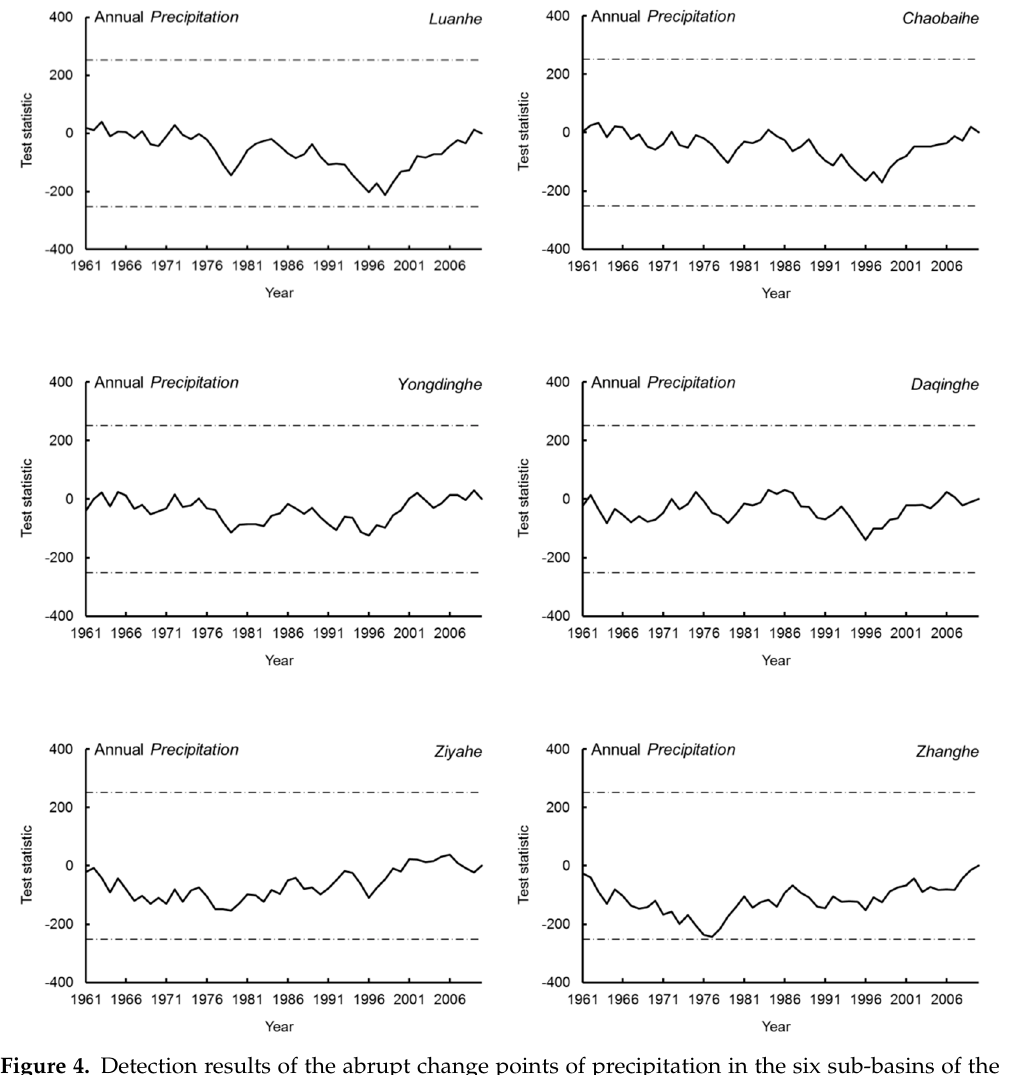
Figure 4. Detection results of the abrupt change points of precipitation in the six sub-basins of the Haihe River Basin.